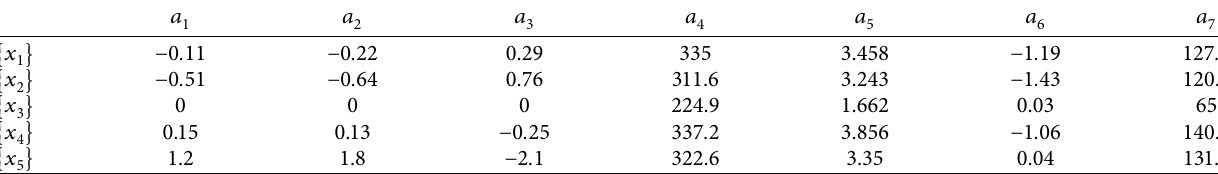
Table 3: Quantitative attributes of five amino acids.